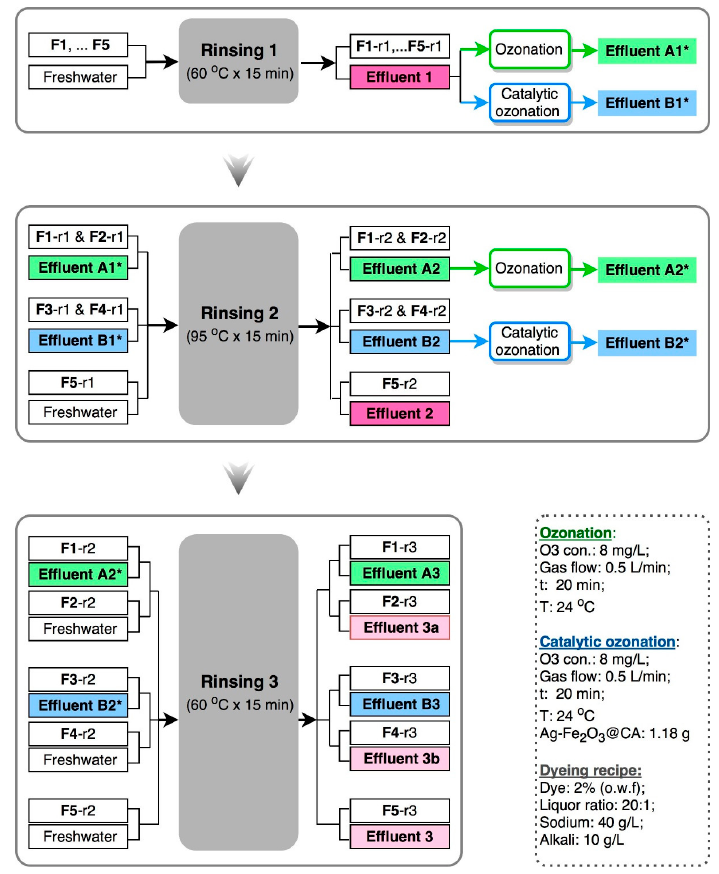
Figure 3. Flow chart for rinsing of fabrics in the wash-off step.